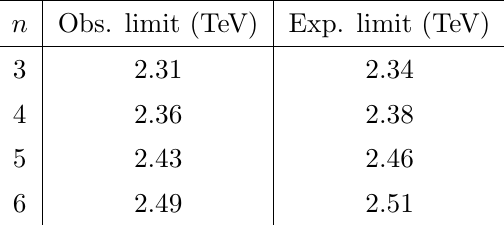
Table 3 . The 95% CL observed and expected lower limits on M D as a function of n , the number of ADD extra